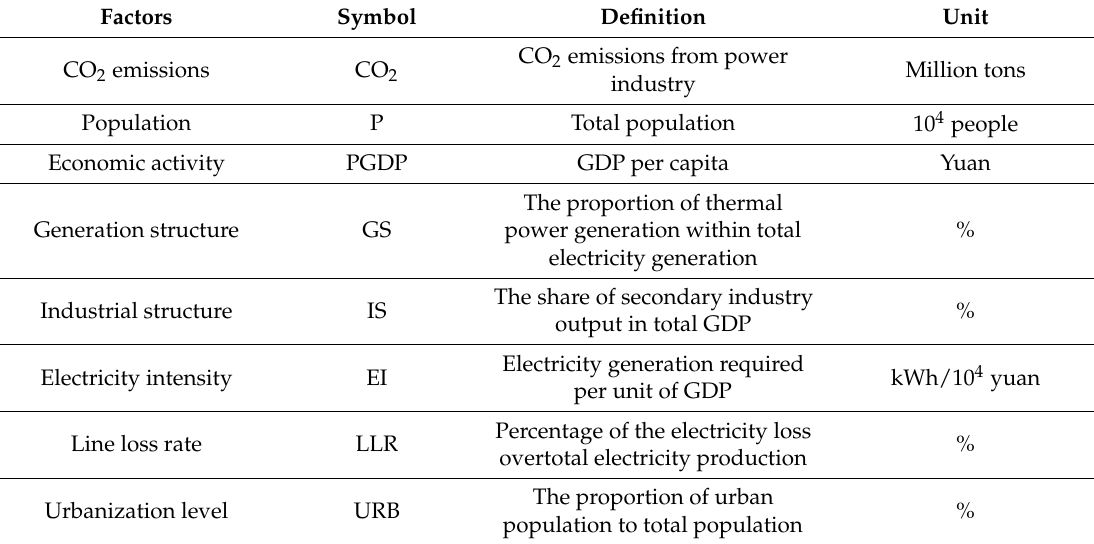
Table 1. Description of variables in this